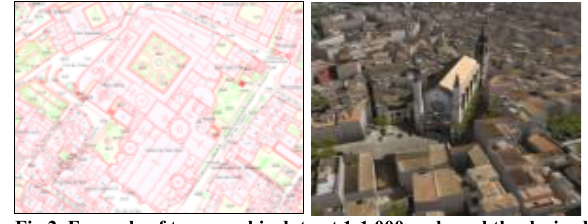
Fig 2. Example of topographic data at 1:1.000 scale and the derived city model